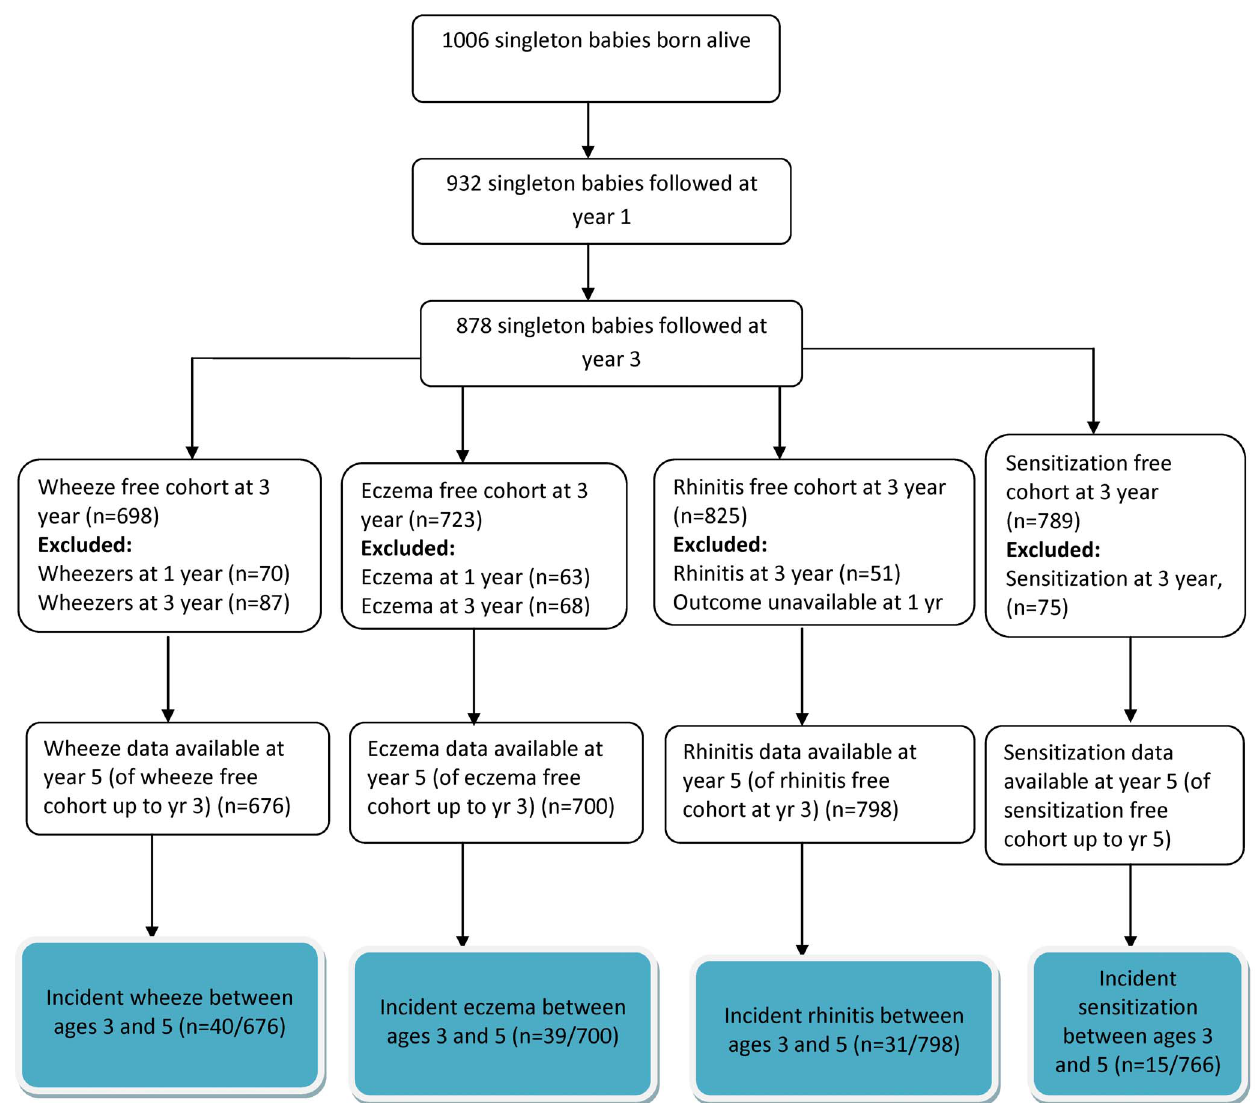
Figure 1. Flow chart showing reporting of symptom outcome measures and sensitization between 1 and 5 years.